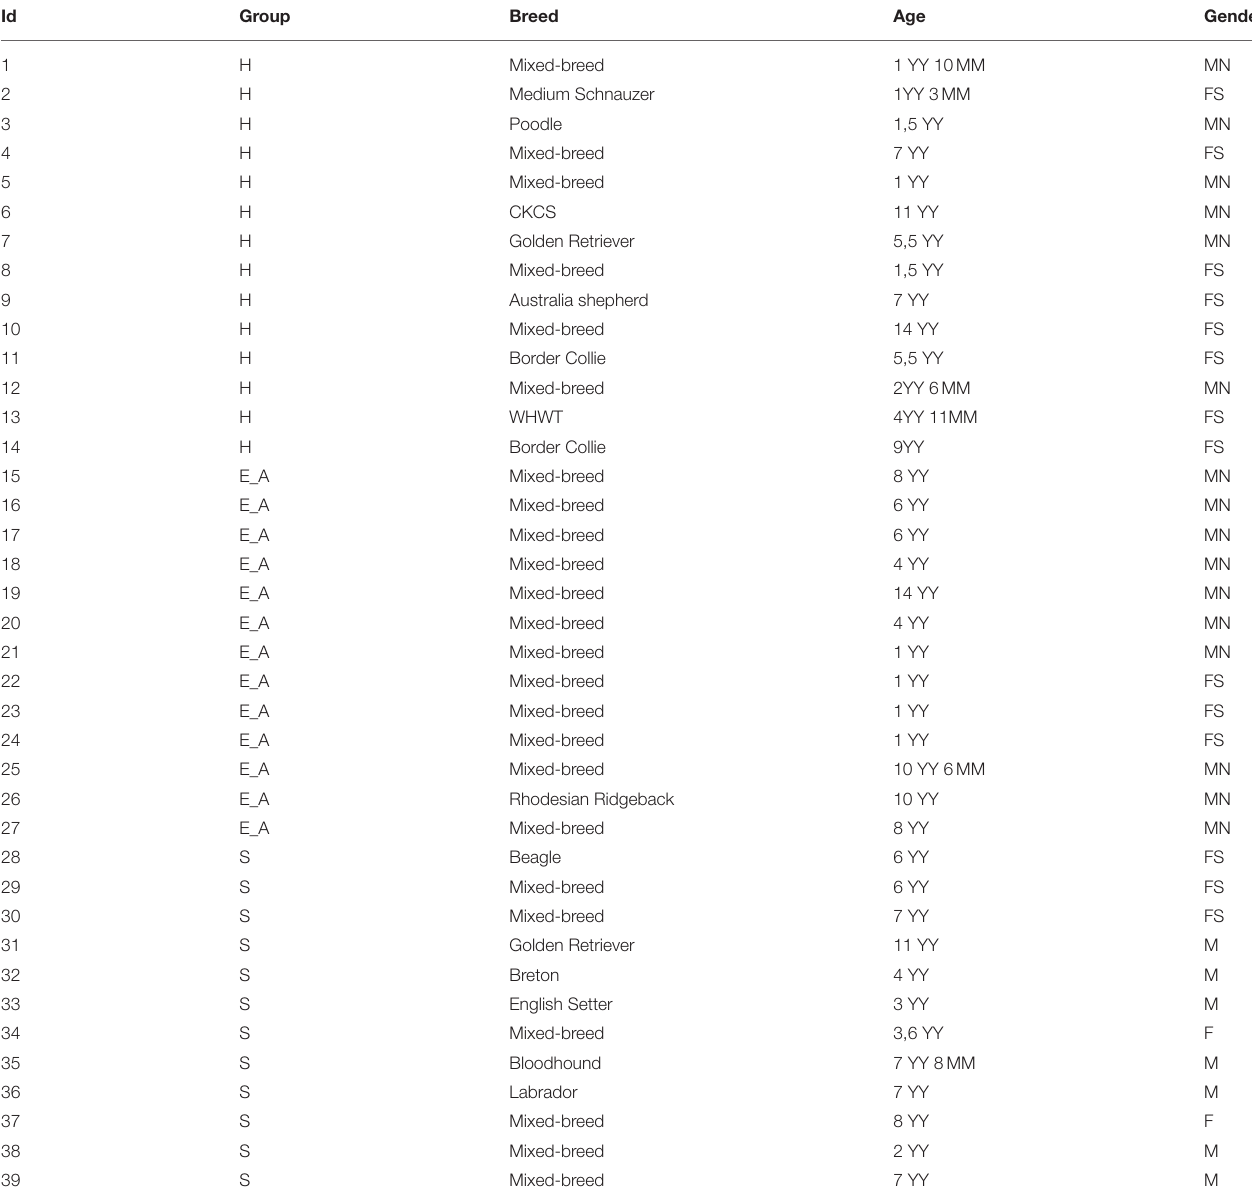
TABLE 2 | Signalment and groups of the dogs enrolled in this